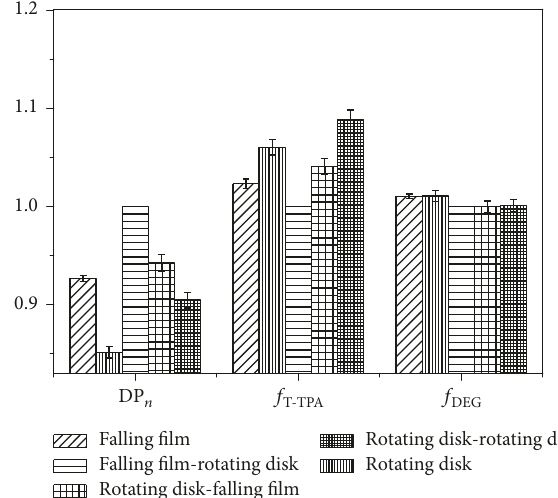
Figure 3: Quality indexes of PET prepared by different reactors (270 ∘ C/1mmHg for the first reactor and 275 ∘ C/0.75 mmHg for the second reactor). Data from the falling film-rotating disk combined reactor is used as